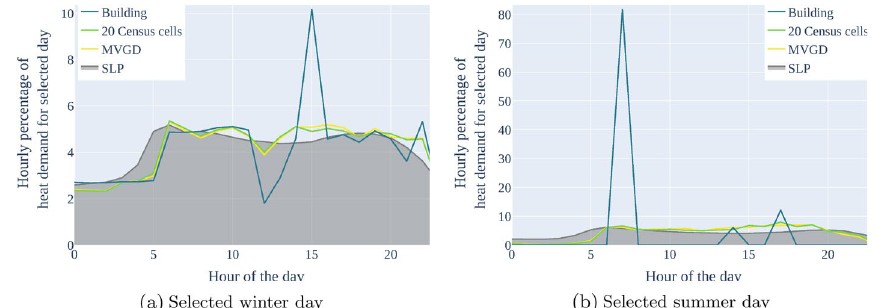
Fig. 6 Heat demand time series for different aggregation